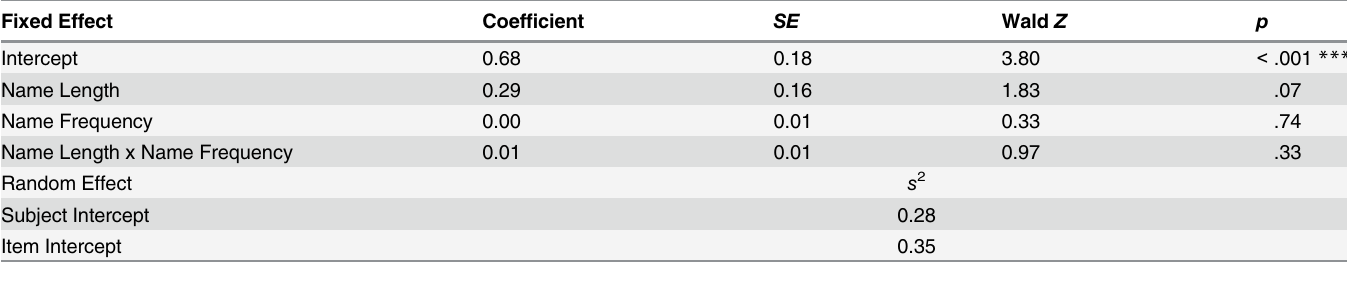
Table 2. Summary of logistic regression predicting the likelihood of a congruent silhouette